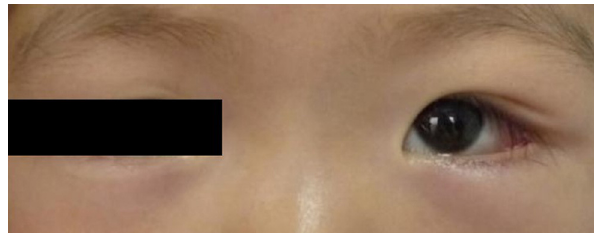
Figure 1: The ocular appearance shows swelling of the lateral superior part and the lower eyelid of the left eye.